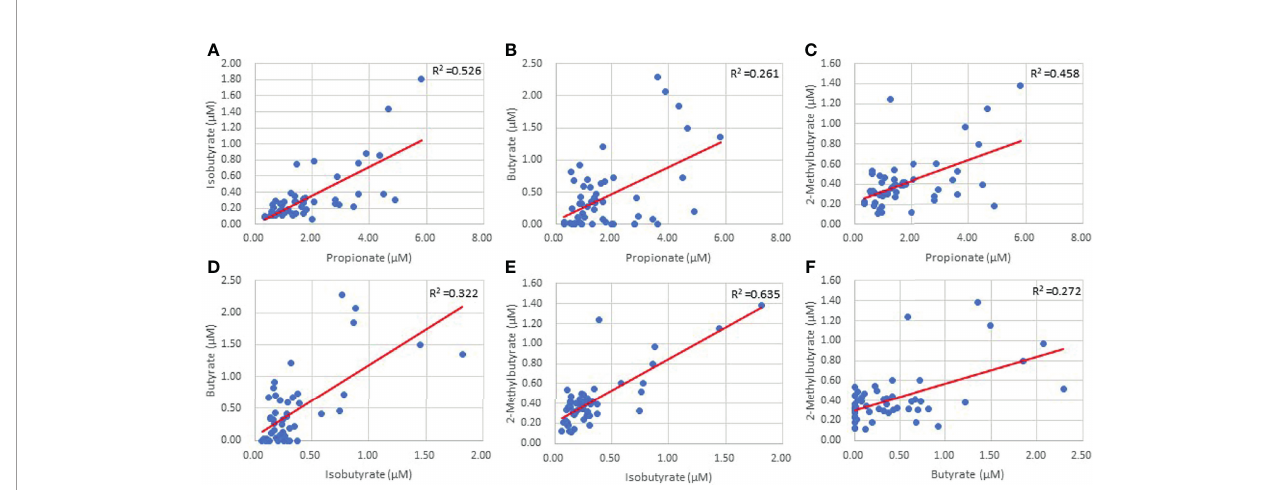
FIGURE 2 | Inter-individual SCFA linear regressions of Propionate and Isobutyrate (A) Propionate and Butyrate (B) Propionate and 2-Methylbutyrate (C) Isobutyrate and Butyrate (D) Isobutyrate and 2-Methylbutyrate (E) and Butyrate and 2-Methylbutyrate (F)